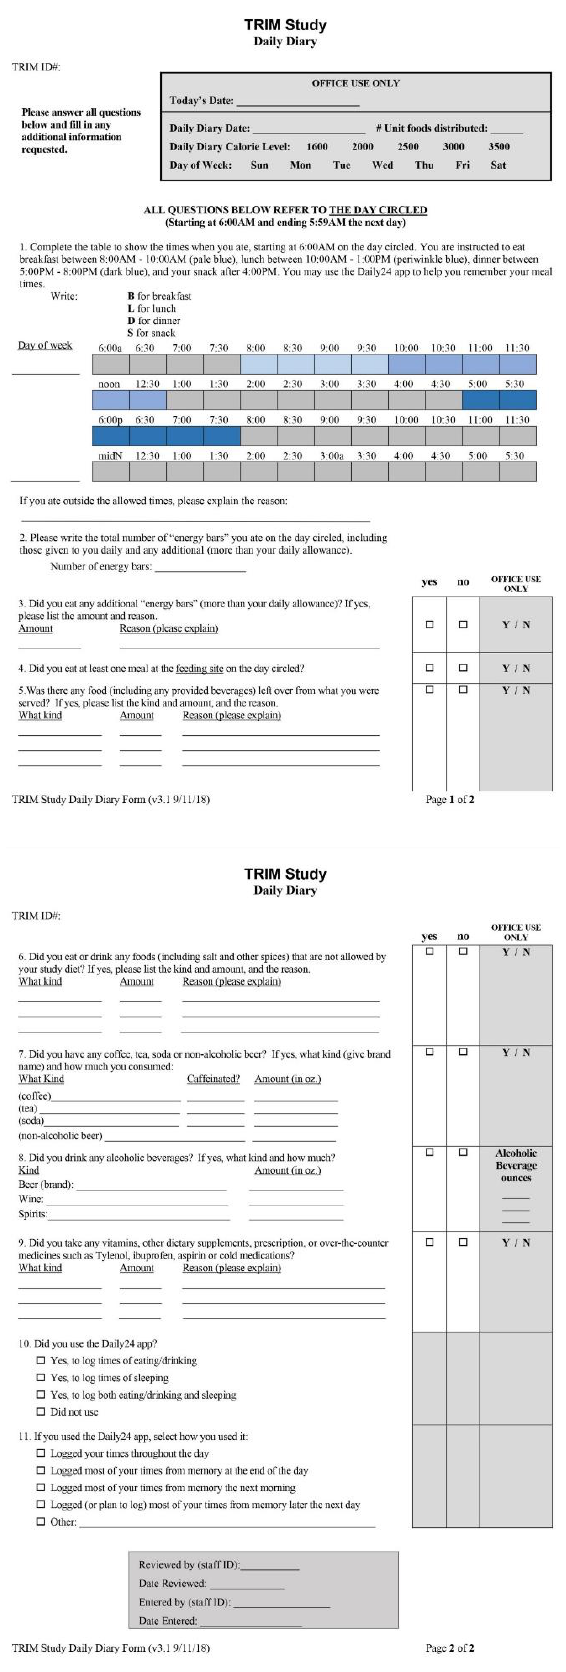
Figure A2. Daily diary form used for adherence measurement in the usual feeding pattern arm.